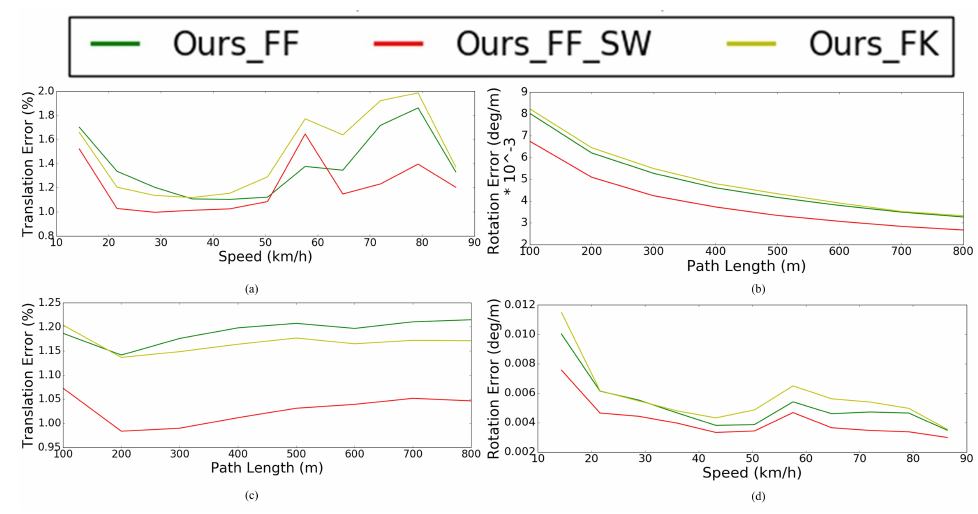
Figure 22. The visual odometry error analysis performed on KITTI training